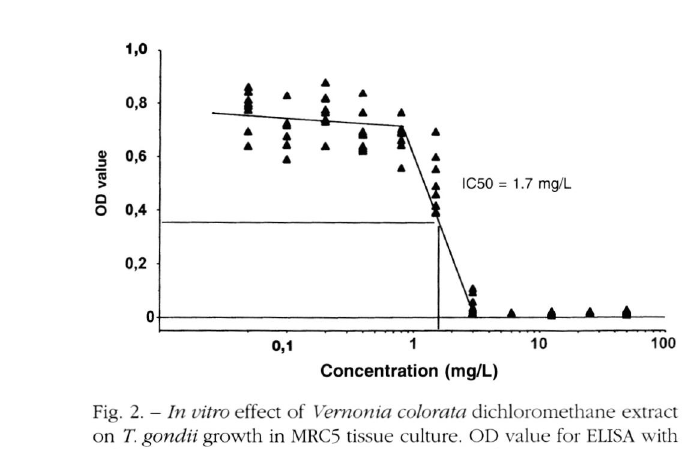
Fig. 2. - In vitro effect of Vemonia colorata dichloromethane extract on T. gondii growth in MKC5 tissue culture. OD value for ELISA with infected monolayers versus concentrations of V. colorata